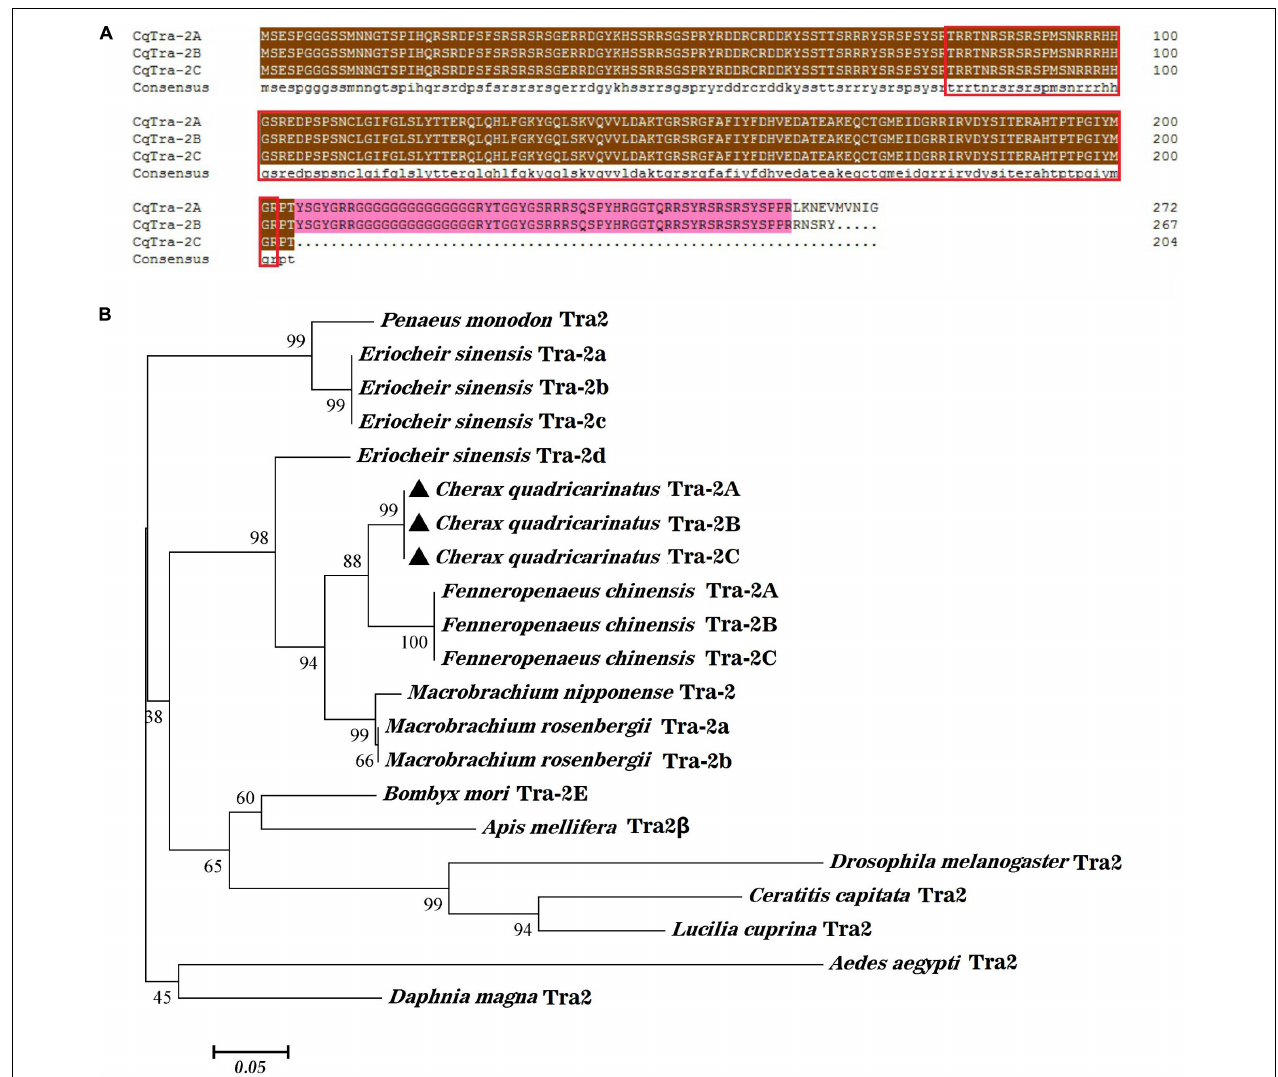
FIGURE 2 | Amino acid alignment and phylogenetic tree analysis of Tra-2. (A) Sequence alignment of three isoforms of Tra-2 in C. quadricarinatus . Red rectangle indicates the RRM domain. (B) Phylogenetic tree construction of Tra-2 protein (Neighbor-Joining method). The black triangle shows the C. quadricarinatus species, and numbers in the branches represent the bootstrap values (%) from 1000 replicates. Species names and Tra2 protein types are listed on the right of the